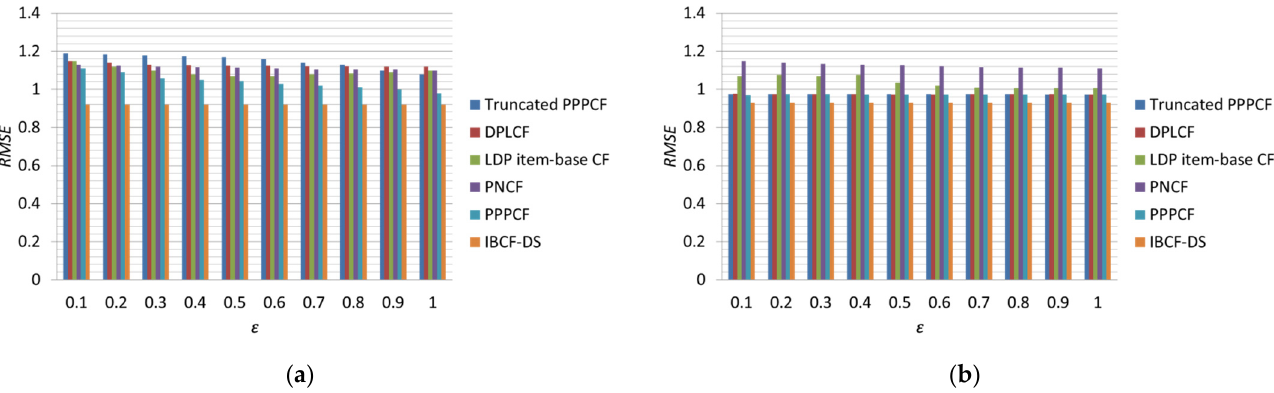
Figure 4. MAE of each algorithm with different privacy budgets 𝜀 . ( a ) Movielens 1M; (b) Yahoo Music.